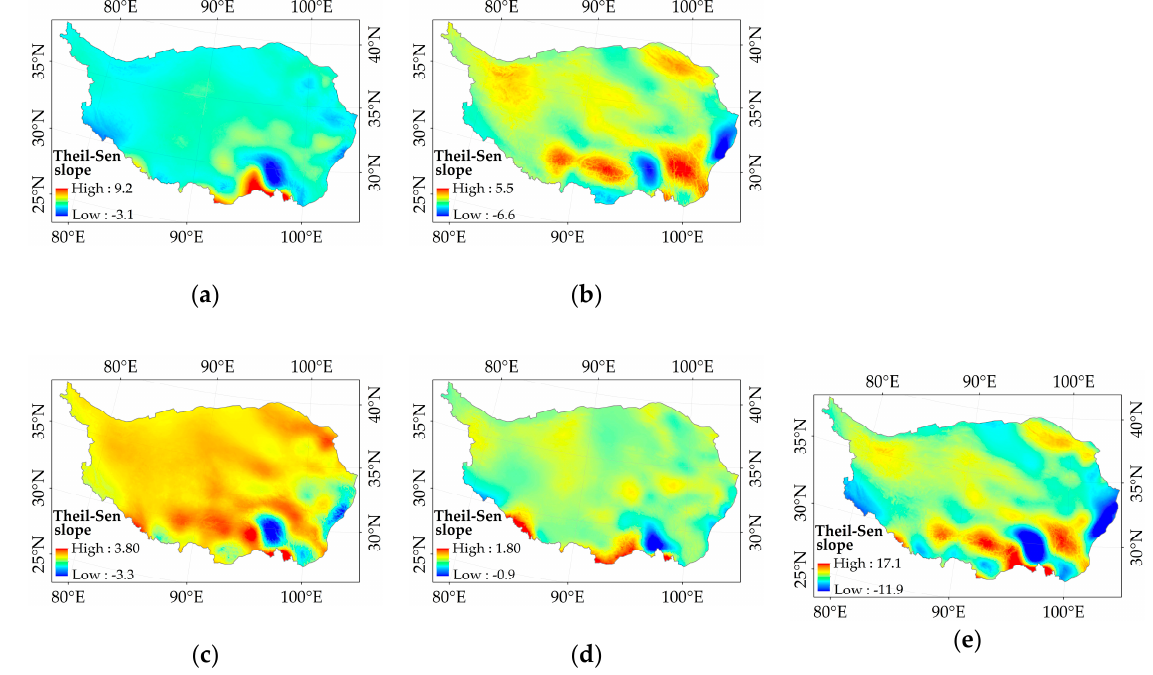
Figure 5. Theil–Sen slope of precipitation on the QTP from 1967 to 2016: ( a ) spring; ( b ) summer; ( c ) autumn; ( d ) winter; ( e ) annual.